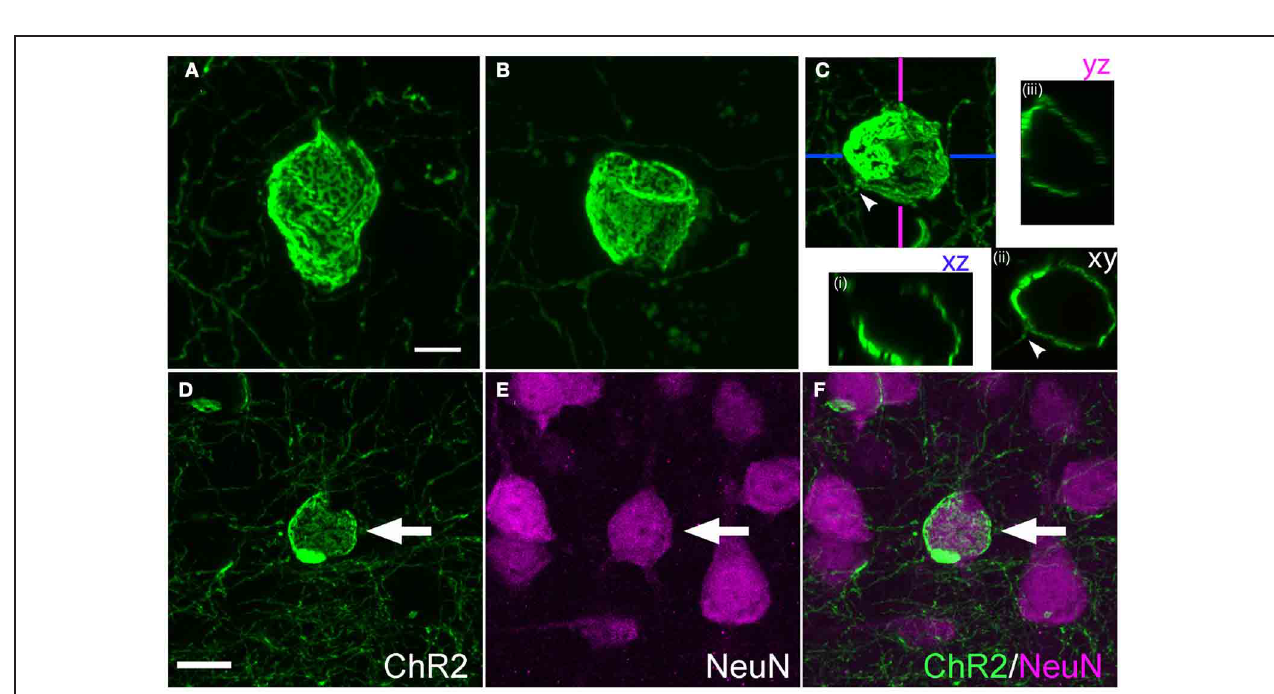
SMI32 antibody. Panels show ChR2 + cylinders in layer 4, co-staining with SMI32 antibody, and overlay showing ChR2 + membrane surrounding dendrite (arrowheads). Insets in (G) , single confocal optical sections showing ChR2 axon, SMI32, and overlay. Scale bar, 10 μ m.